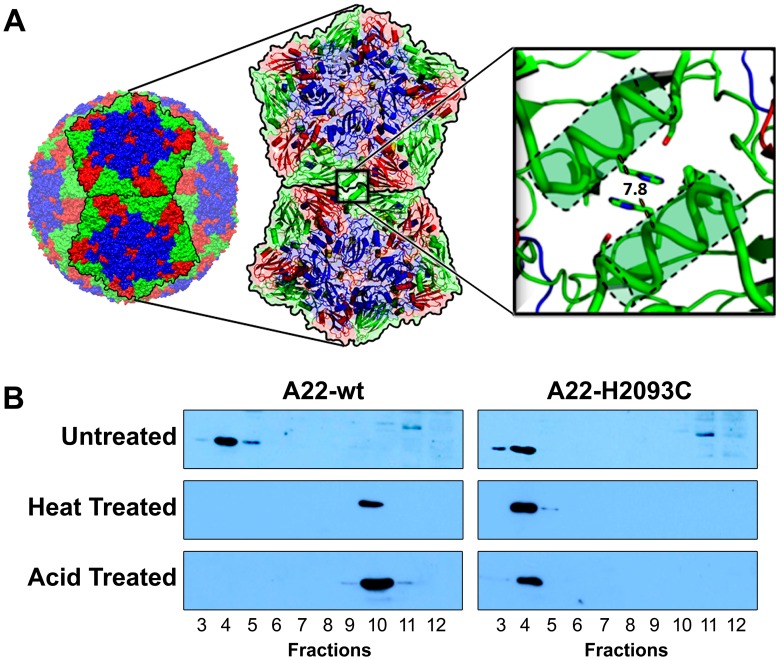
Rational design to produce stable empty capsids of FMDV A22.(a) The crystal structure of FMDV serotype A22 [2] was analysed as described in Materials and Methods. This led to the prediction and modelling of a potential disulphide bond between pentamers by mutation to cysteine of VP2 histidine residue 93, located on the α-helix at the two-fold symmetry axis. (b) Western blot analyses of A22-wt and A22-H2093C empty capsids, expressed from recombinant vaccinia viruses and sedimented through 15–45% sucrose gradients. Each gradient was fractionated from the bottom. FMDV capsid proteins were detected using an anti-FMDV strain A22 polyclonal antibody raised in guinea pigs. Crude extracts were left untreated, heated to 56°C for 2 h or acidified to pH 5.2 for 15 min. Following both heat and acid treatments A22-H2093C capsids remained intact and migrated to fraction 4, as before treatment, whereas A22-wt capsids fractured, remaining near the top of the gradient in fraction 10.